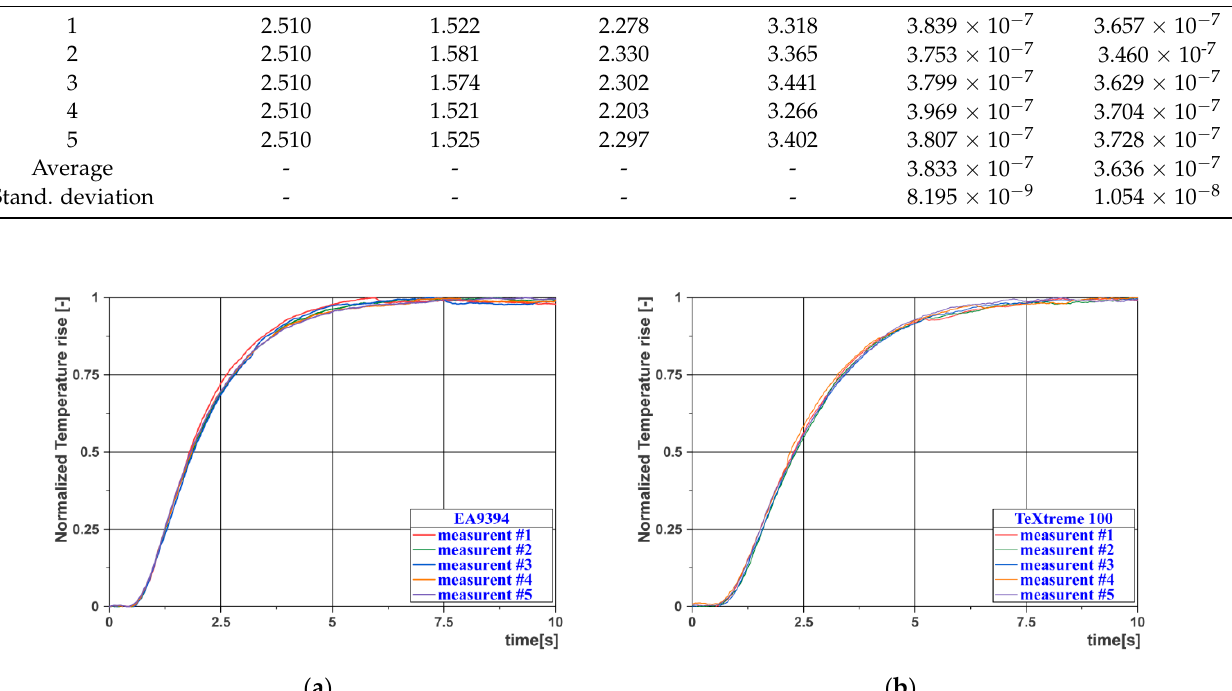
Figure 5. Measurement of thermal diffusivity—heating curves: ( a ) EA9394; ( b ) TeXtreme ® 100. Table 2 . Thermal diffusivity—EA9394.